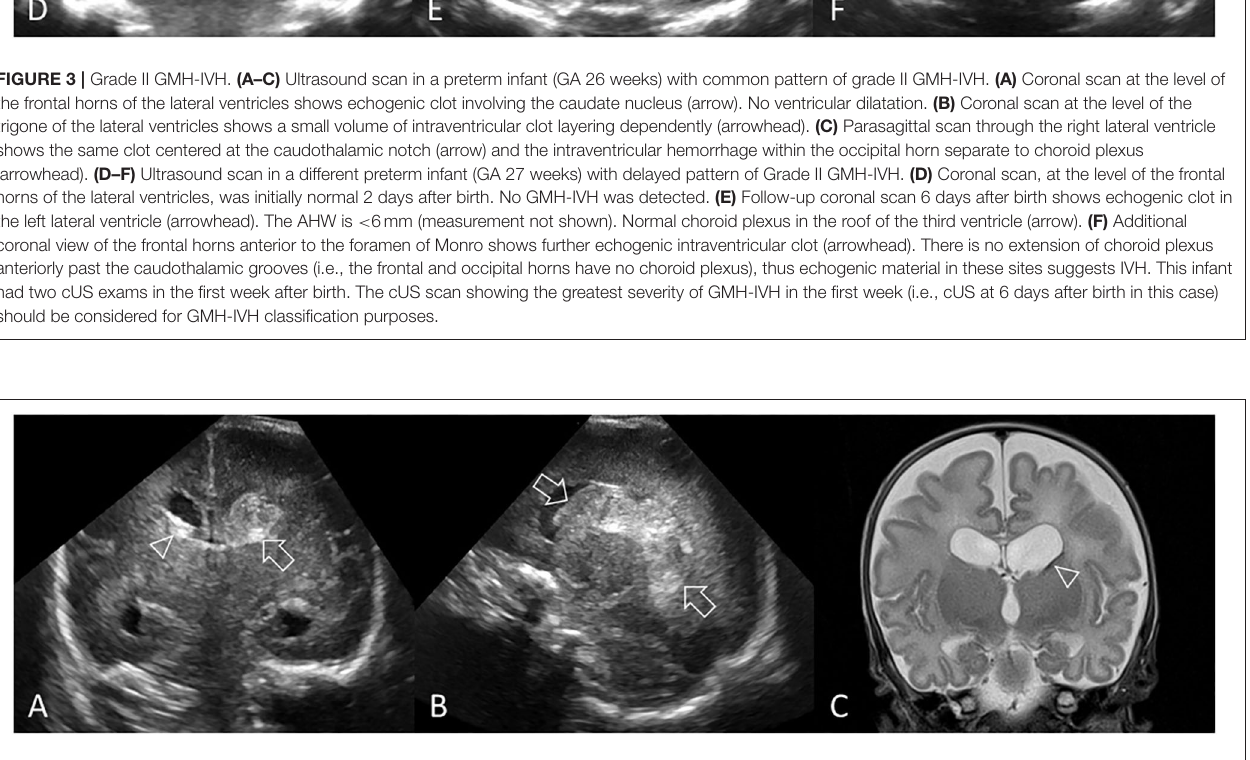
FIGURE 4 | Left-sided grade III GMH-IVH. Ultrasound scan in a preterm infant (GA 25 weeks) showing bilateral IVH. (A) Coronal scan, at the level of the bodies of the lateral ventricles, 2 days after birth shows a large left GMH-IVH (arrow) with intraventricular blood acutely distending its lateral ventricle (AHW = 7mm, measurement not shown). Note also the enlarged temporal ventricular horns. A small amount of blood in the right lateral ventricle (arrowhead) is present. As there is no clear GMH on the right, it is likely that the blood in the right lateral ventricle has flowed, or re-distributed, from the left-sided GMH-IVH. There is ballooning (rounding) of the right frontal ventricular horn (AHW = 6.5mm, measurement not shown). (B) Parasagittal view shows that the left grade III GMH-IVH fills > 50% of the distended lateral ventricle. (C) Coronal T2-weighted MR image 3 months after birth shows subtle hypointense staining at the left caudothalamic notch from hemosiderin/ferritin (arrowhead). No hypointense signal involves the right germinal matrix region, consistent with the earlier ipsilateral IVH having represented “spill-over.” Widened subarachnoid spaces and persistent ventriculomegaly mostly reflects tissue volume loss.